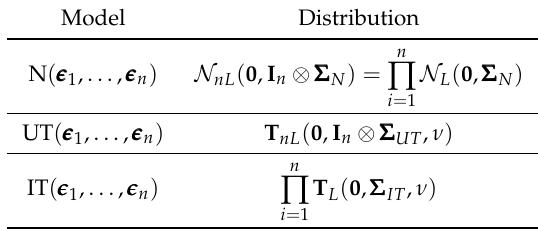
Table 1. Distribution of the error vector (cid:101)(cid:101)(cid:101) in the Gaussian, UT, and IT models. Model